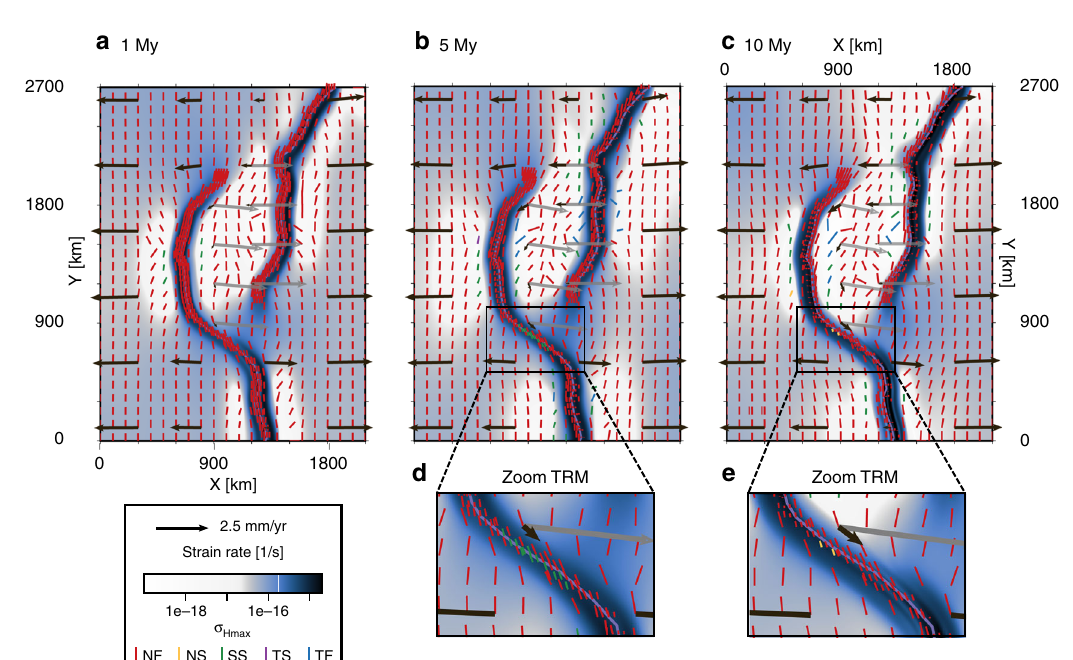
Fig. 5 East African Rift System-speci fi c mobile belt con fi guration EARS model results. a – e Depicted are the strain rate fi eld, maximum horizontal compressive stress σ colored according to the tectonic stress regime, and the velocity vectors at 3-km depth for the East African Rift System initial Hmax mobile belt con fi guration at 1, 5, and 10 My. Black vectors are plotted in the model frame of motion, while the dark-gray vectors represent the microplate motion in a Nubia- fi xed frame. Black and gray vectors are scaled equally. Panels d and e show a zoom-in of the oblique rift section in the boxed area indicated in b and c , respectively. NF normal faulting, NS normal and strike – slip faulting, SS strike – slip faulting, TS thrust and strike – slip faulting, TF thrust